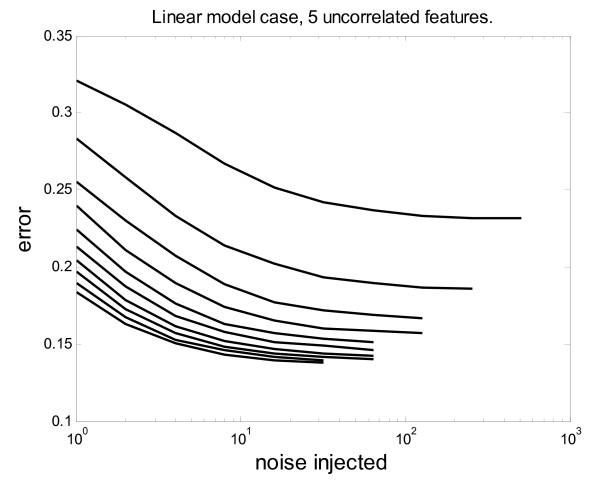
Effects of different amounts of noise for uncorrelated linear model. Classification error is plotted as a function of the amount of noise injection. Each line corresponds to a fixed training sample size, from 10 to 100 for every 10 sample points, the highest line corresponding to 10 sample points and the lowest corresponding to 100 sample points.